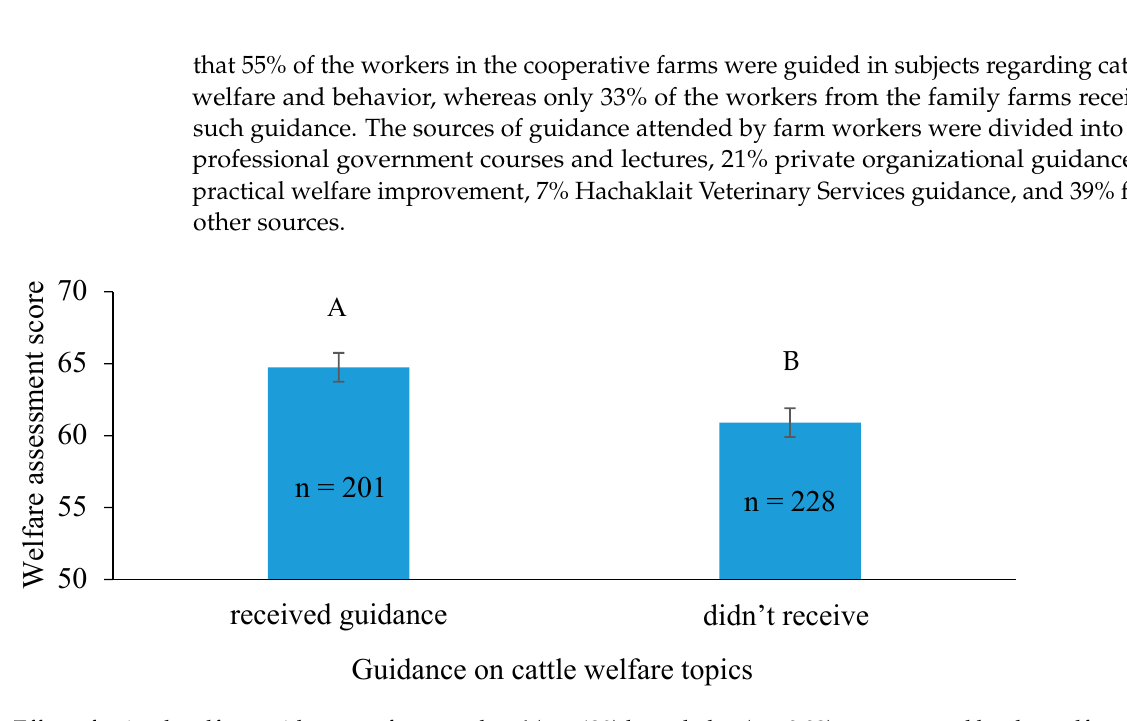
Figure 3. Effect of animal welfare guidance on farm workers’ ( n = 429) knowledge ( p = 0.02), as expressed by the welfare assessment scores, presented as least squares (LS) means ± SE. Letters “A” and “B” signify statistical differences between groups.